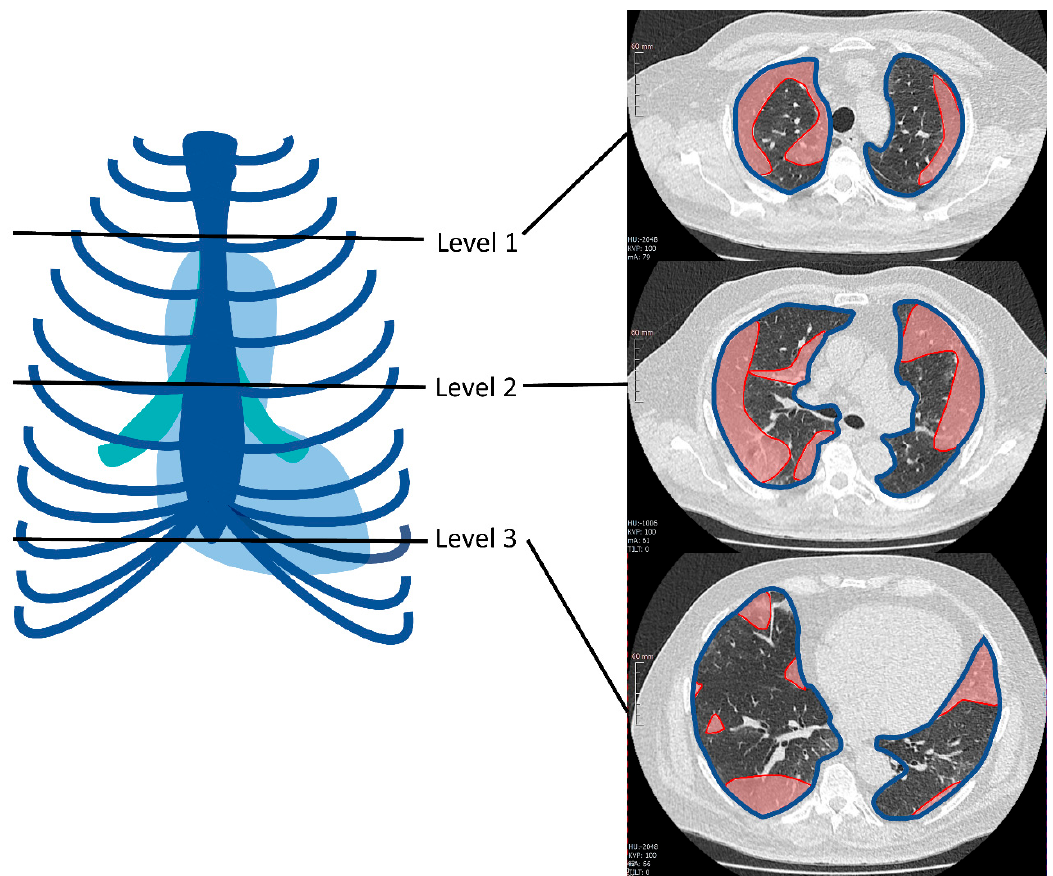
Figure 1. Example of regions of interest (ROI)-based semi-quantitative assessment of lung area involved in COVID-19 findings at the three levels chosen as standard: at the level of the aortic arch, at the level of the tracheal bifurcation, and at the inferior end of the xiphoid. Highlighted in red: area of involved lung parenchyma; the blue line outlines the total lung area in this section.